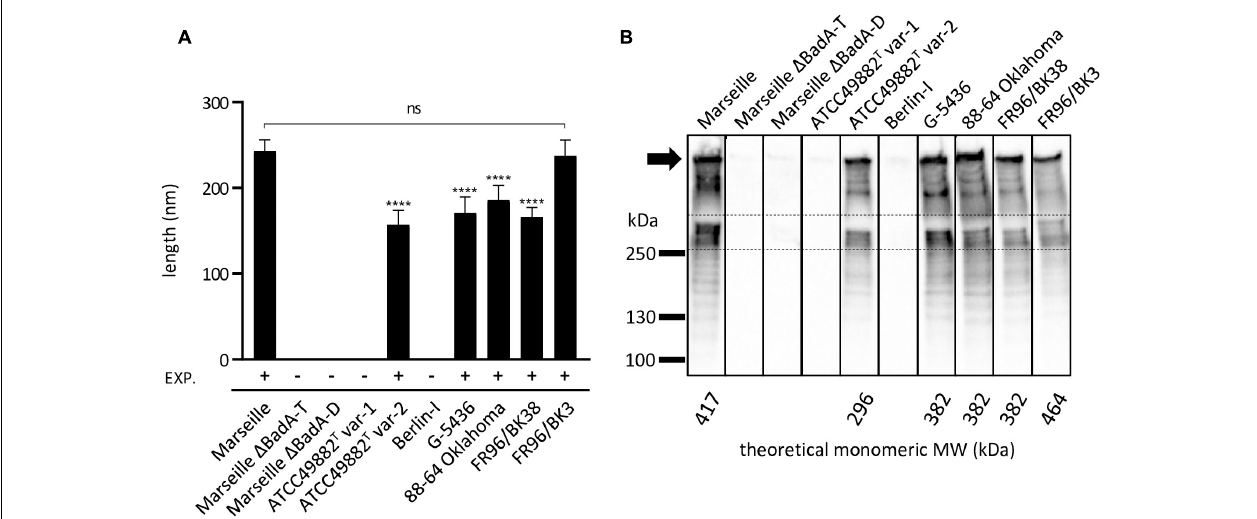
FIGURE 6 | Length analysis of surface-expressed BadA and their corresponding molecular weight of B. henselae strains. (A) The average length of expressed BadA was measured using 30-50 TEM images of bacterial cells per strain. The individual average BadA fibre lengths of strains ATCC49882 T var-2 (157 nm), G-5436 (171 nm), 88-66 Oklahoma (186 nm) and FR96/BK38 (166 nm) are significantly shorter (**** p < 0.0001) compared to those of strains Marseille (243 nm) and FR96/BK3 (238 nm). The length of the last two strains do not differ significantly (ns). Strains ATCC49882 T var-1, Berlin-I, Marseille (cid:49) BadA-T and Marseille (cid:49) BadA-D do not express BadA. EXP.: expression of BadA. (B) BadA expression of the various B. henselae strains is visualised by Western blotting. The band between the dashed lines is considered monomeric BadA protein. Marseille and FR96/BK3 display a higher MW band around the predicted monomeric BadA protein. The numerous lower MW-bands are considered degradation products of the high MW BadA protein. The uppermost band is presumably trimeric BadA protein stuck in the pocket of the gel (black arrow). Bands in between the trimeric and monomeric protein are also considered degradation products of trimeric BadA. All strains were analysed on a single nitrocellulose blot, the order of columns has been rearranged in silico .